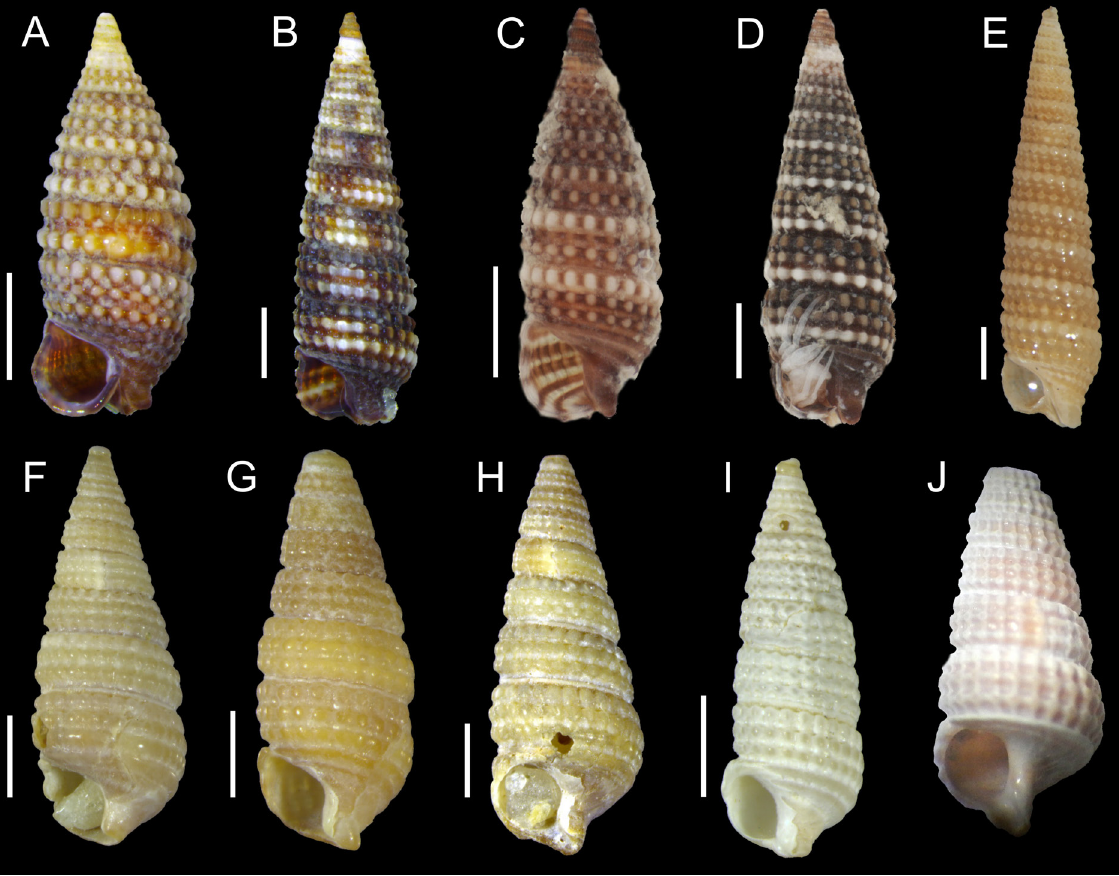
Fig. 84. Fresh and worn specimens found in southern Brazil and Uruguay/Argentina. A . Nanaphora verbernei (Moolenbeek & Faber, 1989) , MNRJ 28956*. B . Nototriphora decorata (C.B. Adams, 1850)